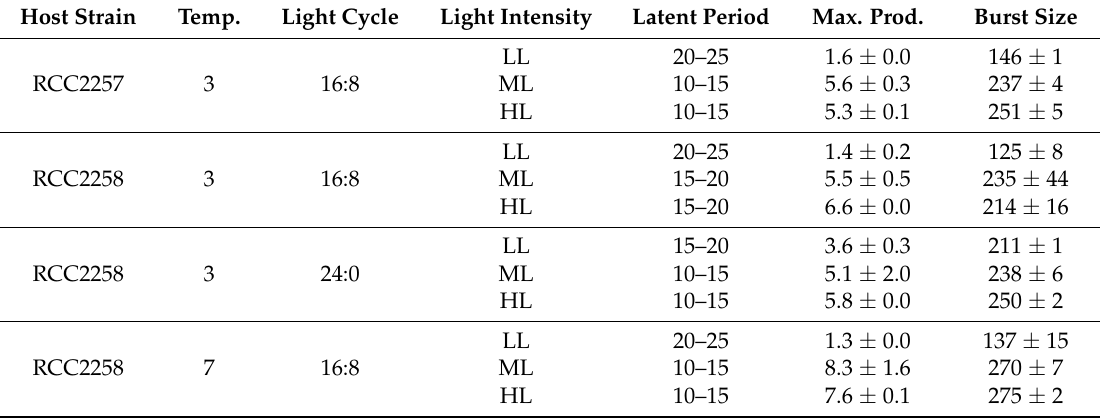
Table 2. Virus growth characteristics, i.e., latent period (h), maximum production rate (Max. Prod., RCC2258 and RCC2257 cultured at two temperatures (Temp., 3 ◦ C and 7 ◦ C), under a 16:8 h and 24:0 h light:dark cycle at low (LL), mid (ML) and high (HL) light